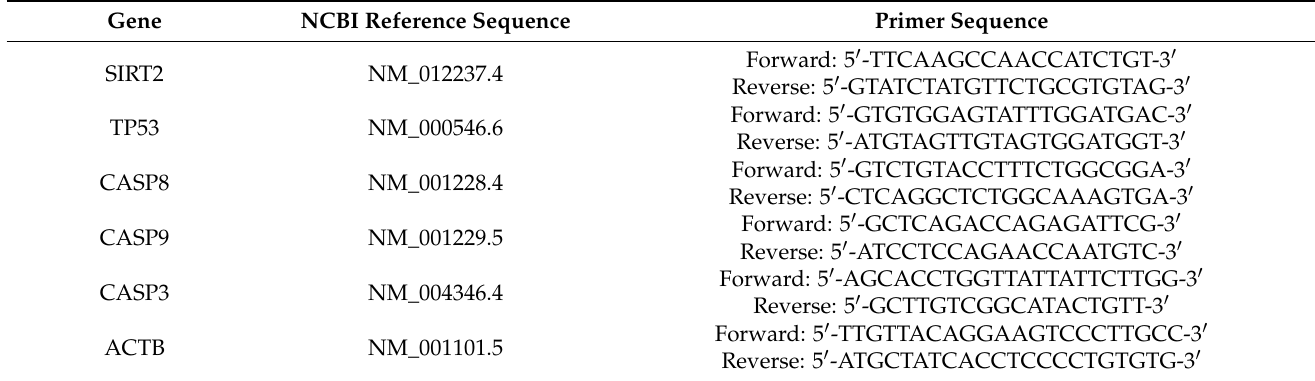
Table 1. Oligonucleotide primer sequences used for real-time